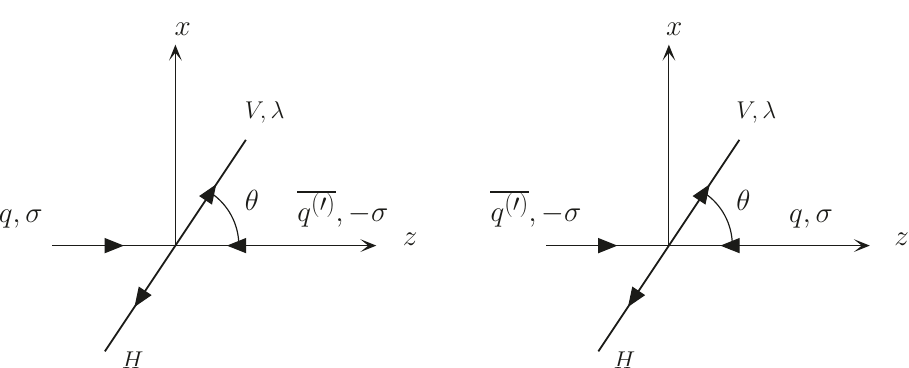
Figure 3 . Left : the qq ( 0 ) c.m. frame, where the quark ( q ) moves along the positive direction of (cid:21) the z -axis. The production amplitudes ( qq ( 0 ) ) are evaluated in this frame. Right : the q ( 0 ) q c.m. (cid:27) M frame, where the antiquark ( q ( 0 ) ) moves along the positive direction of the z -axis. The production (cid:21) amplitudes ( q ( 0 ) q ) are evaluated in this frame. The quark helicity (cid:27) (= (cid:27) M helicity (cid:27) and the weak boson helicity (cid:21) (= 1 ; 0) are shown, and the polar angle (cid:18) of the weak (cid:0) (cid:6) boson V from the z -axis is denoted in both the